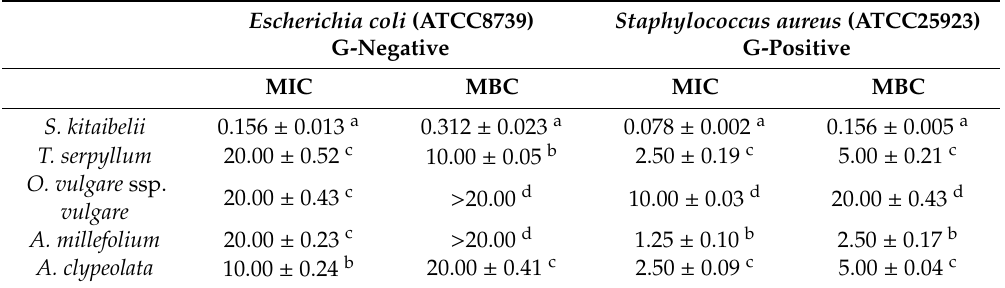
Table 2. Antimicrobial activity of tested EO against Escherichia coli and Staphylococcus aureus ( µ L / mL). Escherichia coli (ATCC8739) Staphylococcus aureus G-Negative